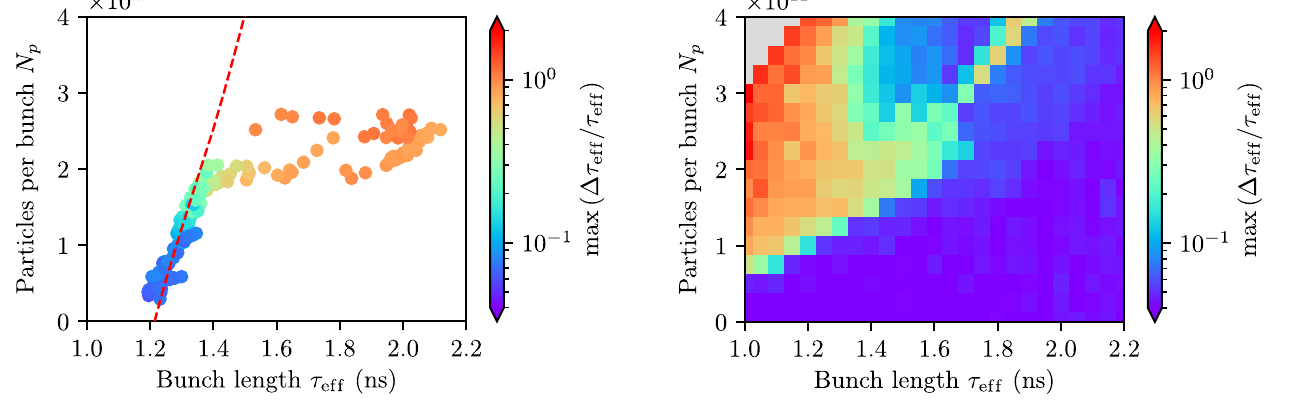
FIG. 18. Longitudinal stability map obtained from BL on D simulations for the SPS impedance model after LS2 (orange curve in Fig. 1) and single-rf configuration. Background colors indicate the maximum relative oscillation amplitude of the bunch length. The SPS parameters are according to Table